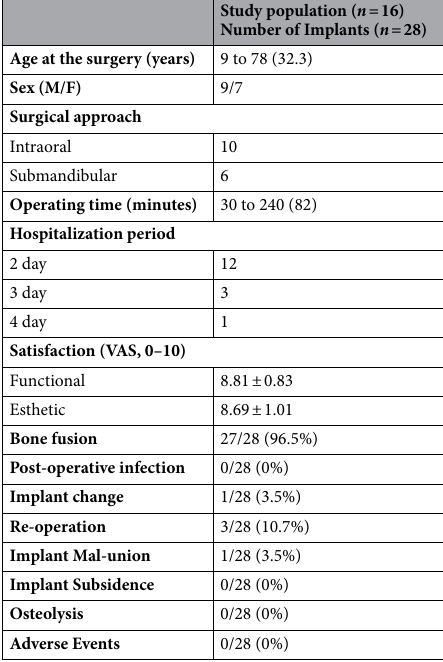
Table 1. Surgical results and complications. VAS visual analog